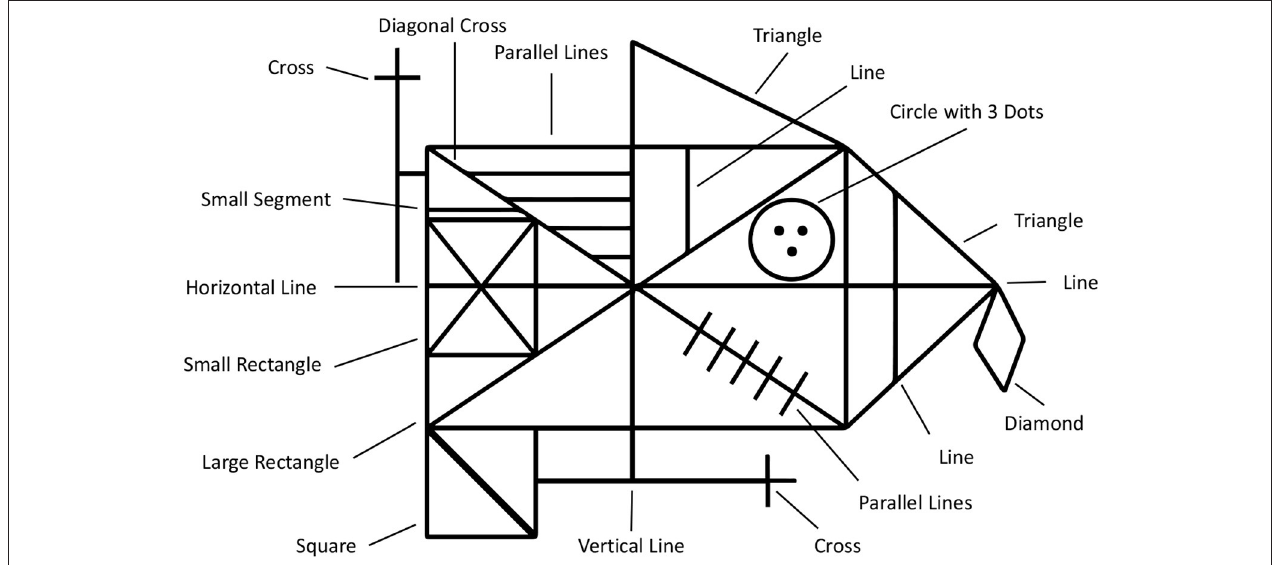
FIGURE 2 | The Rey-osterrieth complex figure (ROCF) is composed of 18